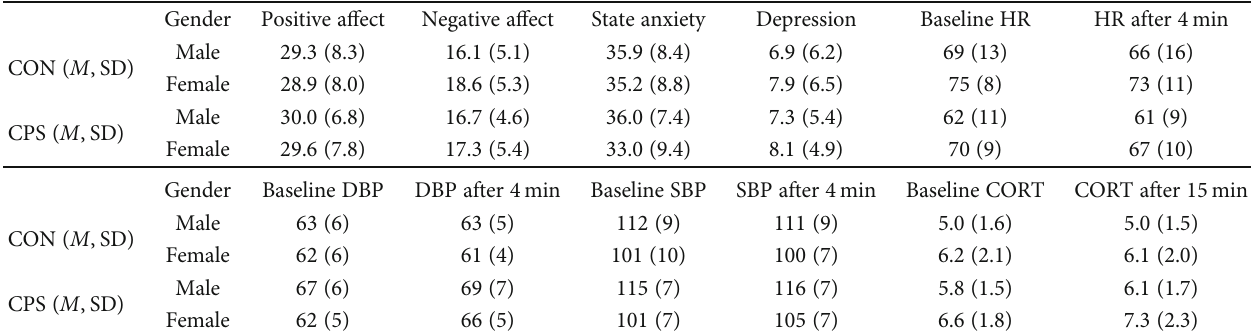
Table 2: Preexperiment mood and physiological measurements before and after control or CPS treatment.